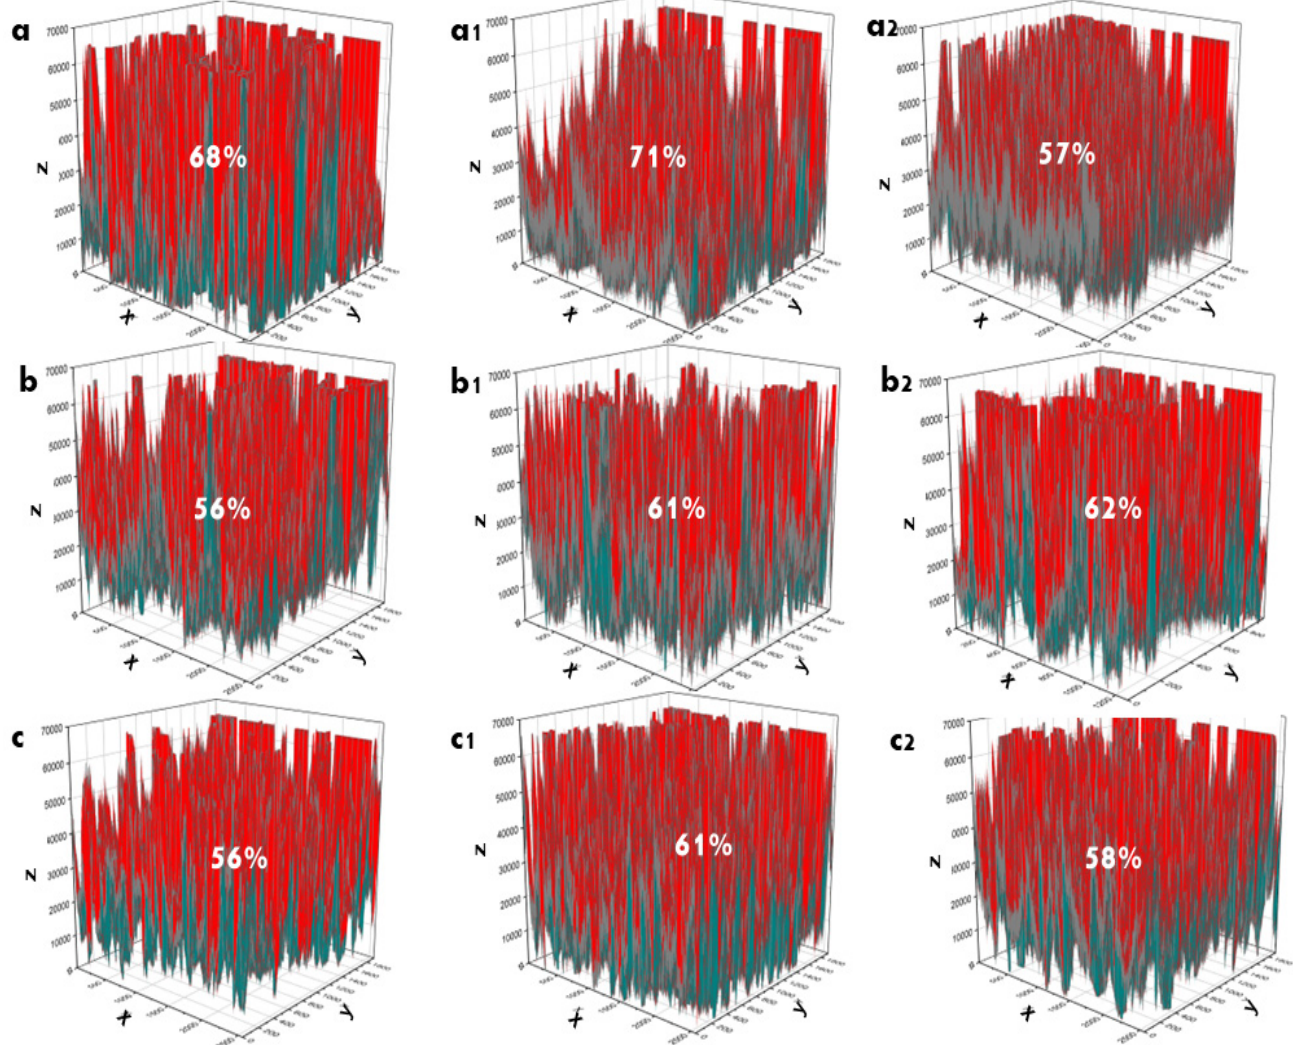
Figure 9. Surface porosity (%) of Ti/HAp-1 ( a – a2 ), Ti/HAp-3 ( b – b2 ), and Ti/HAp-coll ( c – c2 ). Before immersion ( a , b , c ), 3 days immersion ( a1 , b1 , c1 ), and 10 days immersion ( a2 , b2 , c2 ).